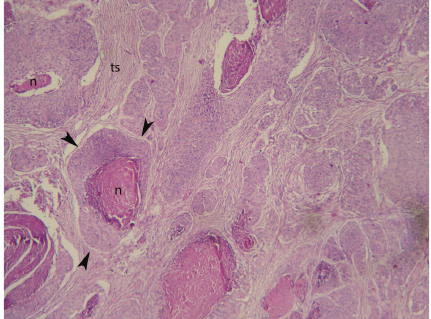
Figure 3: Microphotograph shows tumor islets (arrowheads) con- taining a central area of necrosis formed by atypical squamous cells as well as keratin globules H&E × 40. n: necrosis, ts: tumor